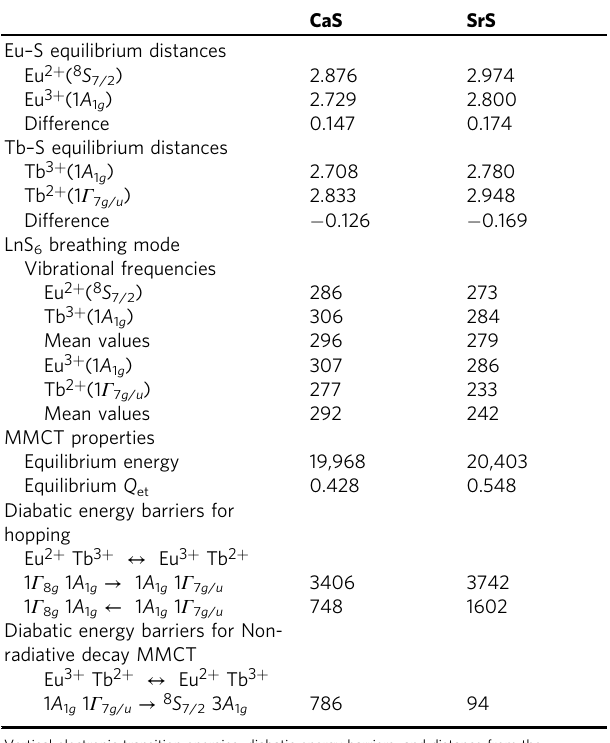
Vertical electronic transition energies, diabatic energy barriers, and distance from the con fi gurational coordinate diagrams. Γ 7 g and Γ 7 u are the lowest levels of Tb 2 + in CaS and SrS, respectively. Energies and vibrational frequencies in cm − 1 ; distances in Å